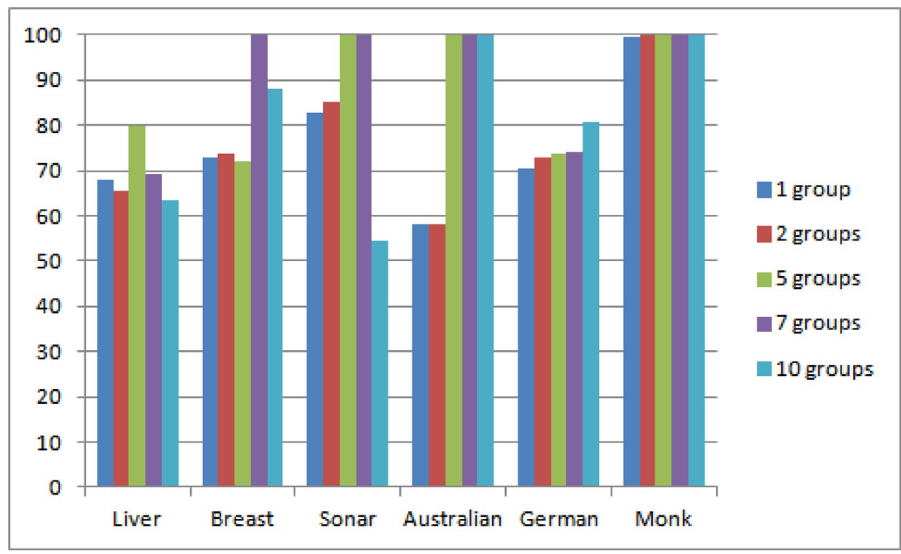
Fig 6. Performance comparison(%) of different